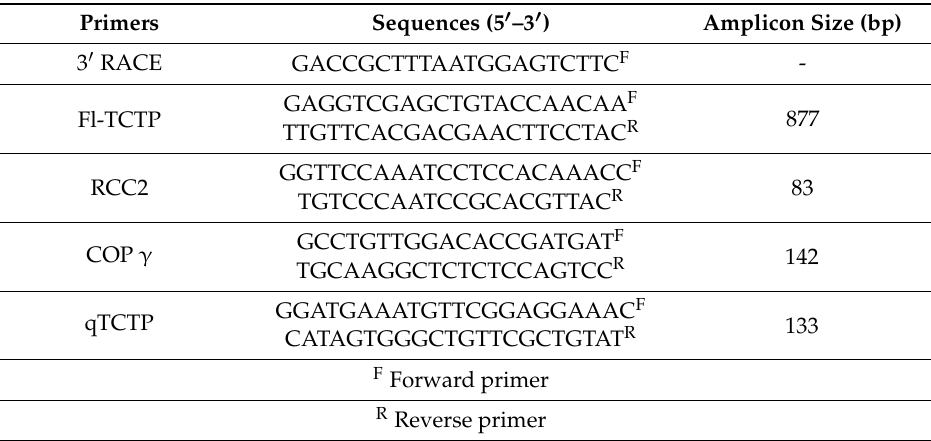
Table 1. Specific primers used in this study.